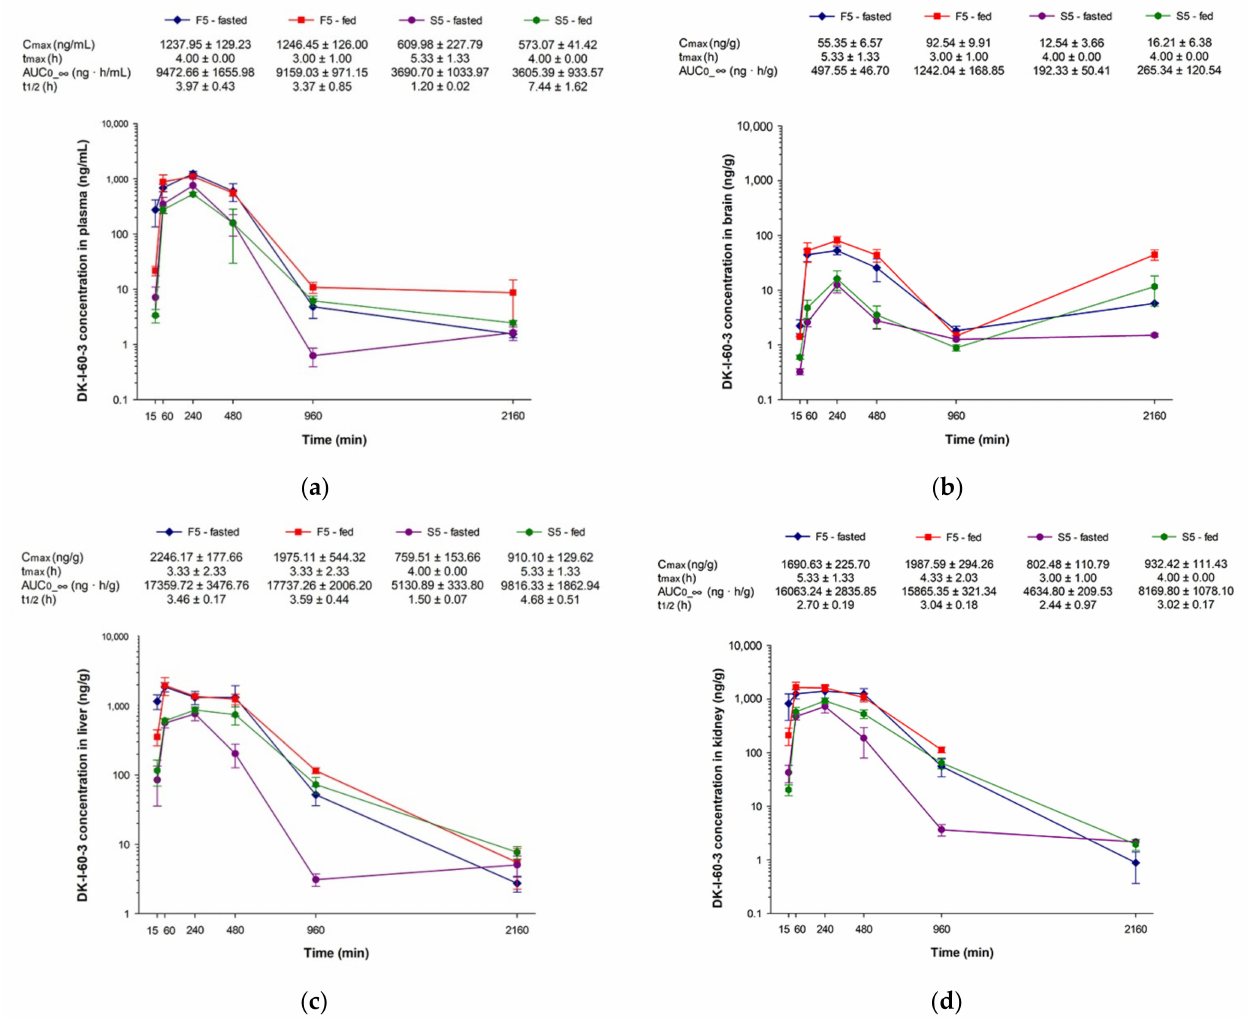
Figure 7. Concentration versus time curves and calculated pharmacokinetic parameters of nanocrystal dispersion (F5) and suspension (S5) in ( a ) plasma, ( b ) brain, ( c ) liver, and ( d ) kidney after oral administration in rats (n = 3 per time point) at a dose of 10 mg/kg, in fasted and fed state (C max —maximum concentration, t max —time of maximum concentration, t 1/2 —terminal elimination half-life, AUC 0- ∞ —area under the concentration versus time curve). Terminal elimination half-life in the brain was not calculated due to erratic concentration-time